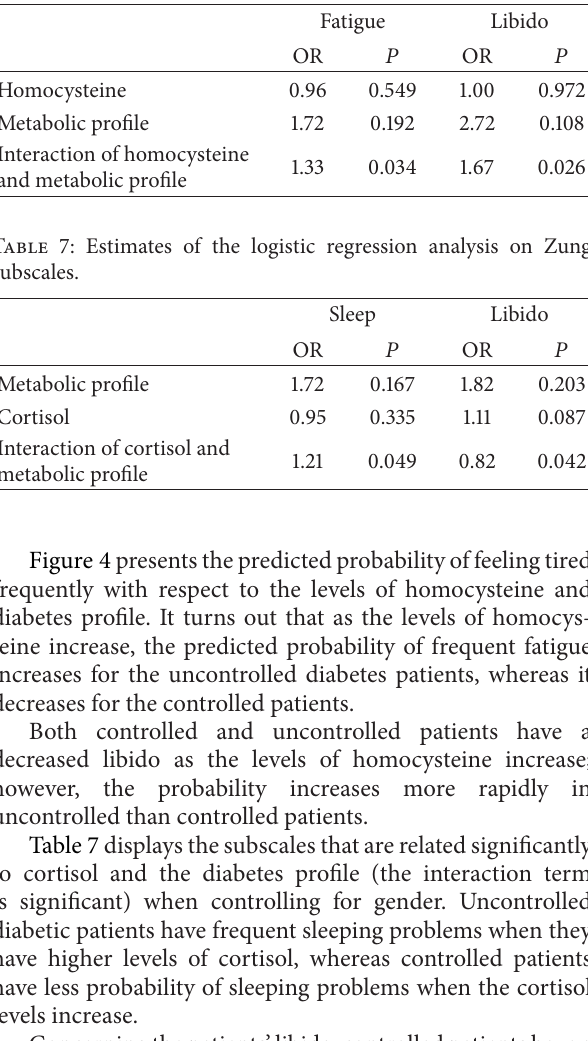
Table 6: Estimates of the logistic regression analysis on Zung subscales.